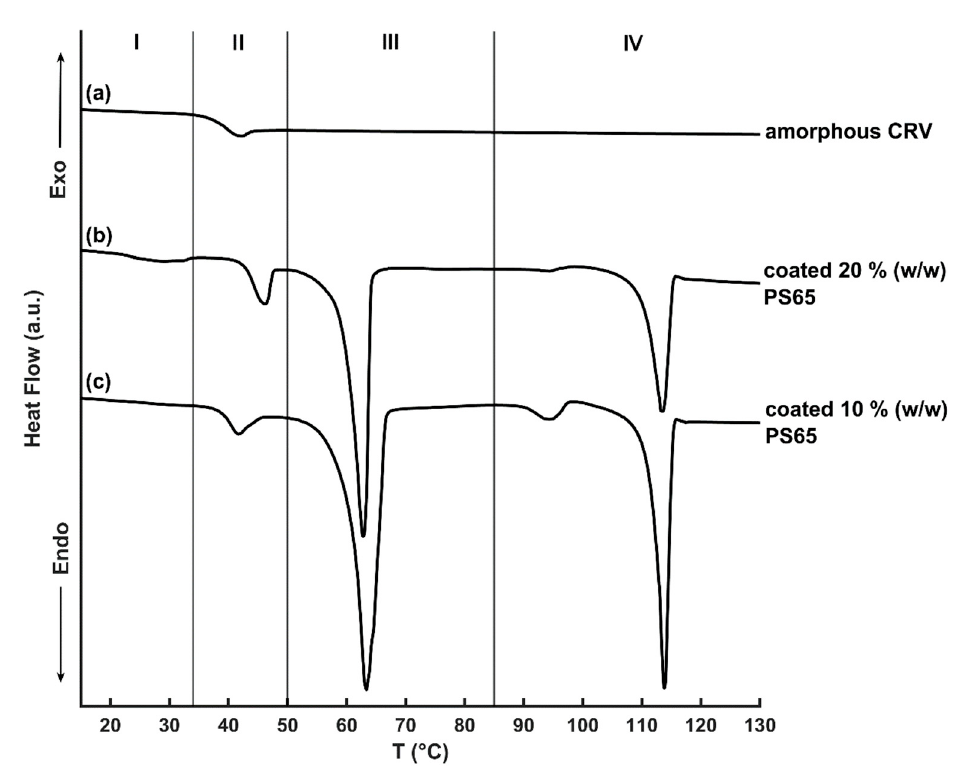
Figure 4. DSC thermograms of freshly amorphous CRV ( a ) and coated amorphous CRV particles (20% ( w/w ) PS65 ( b ) and 10% ( w/w ) PS65 ( c )) after 1 month of storage under dry conditions. The Zones I–IV correspond to the following thermal events: I—melting of PS65, II—glass transition of amorphous CRV, III—melting of tripalmitin and IV—recrystallization and/or melting of crystalline CRV.